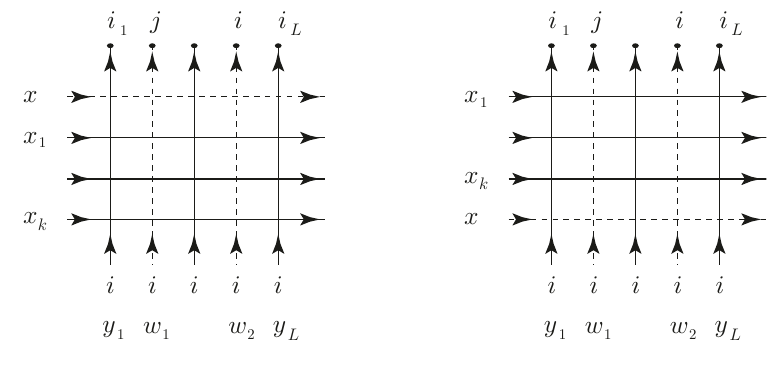
Figure 8 . Lattice